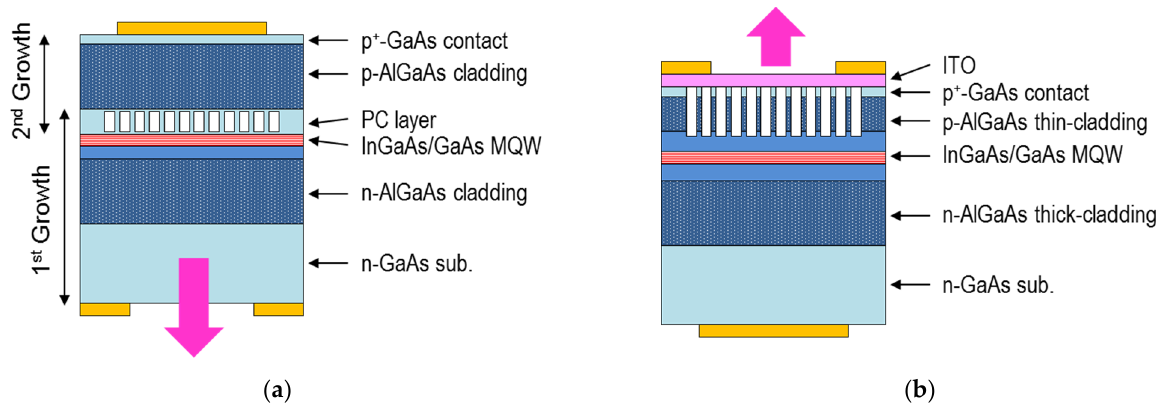
Figure 1. The schematic structures of ( a ) air-hole PC-SEL and ( b ) air-pillar PC-SEL under investigation.